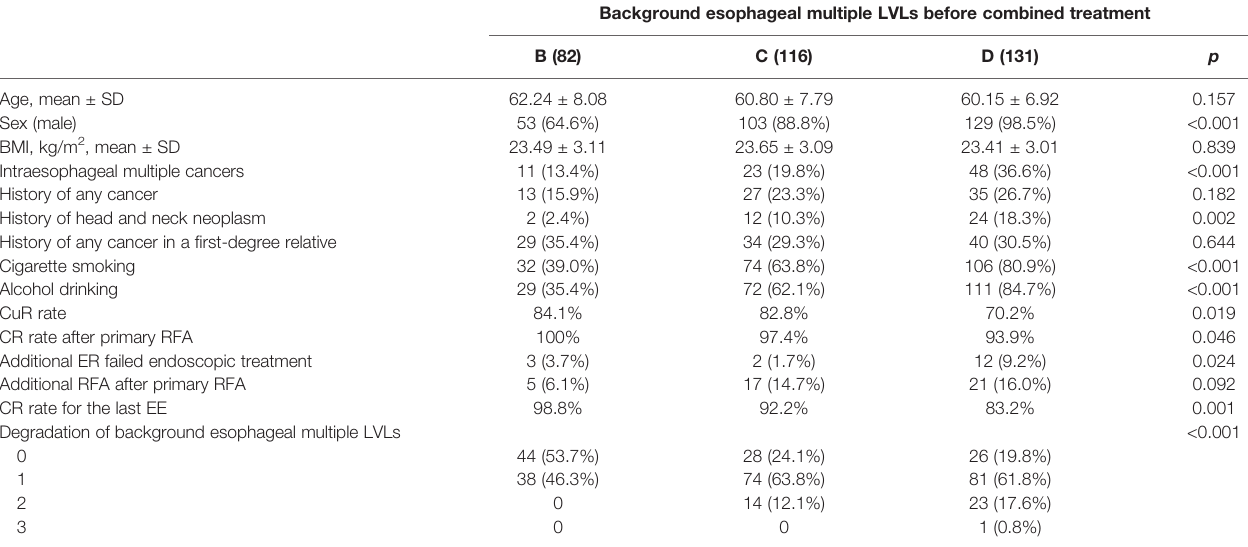
TABLE 5 | Comparison of patient characteristics and clinical results among different groups of background esophageal multiple